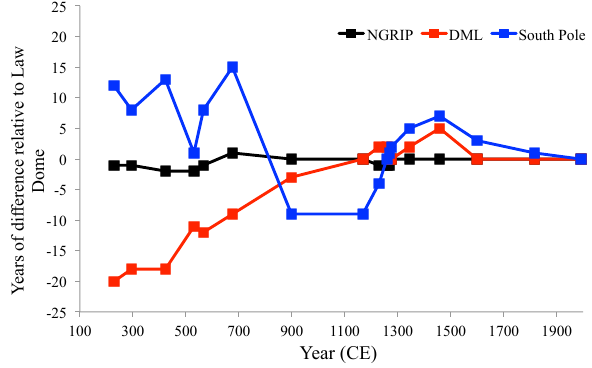
Fig. 2. Comparison of Law Dome to other ice core volcanic records. Figure 2 illustrates the number of years of difference between the dating of volcanic events common to the NGRIP, DML and South Pole (SP045C) ice cores relative to Law Dome. Volcanic event dates have been matched on eruption signature. Squares indicate vol- canic event dates. DML and South Pole cores are from relatively low accumulation sites (0.073 and 0.075myr − 1 ice equivalent re- spectively), which may be a factor in the variability and drifting of those timescales relative to Law Dome (0.70myr − 1 ice equiva- lent). NGRIP at (0.19myr − 1 ice equivalent) still agrees well with Law